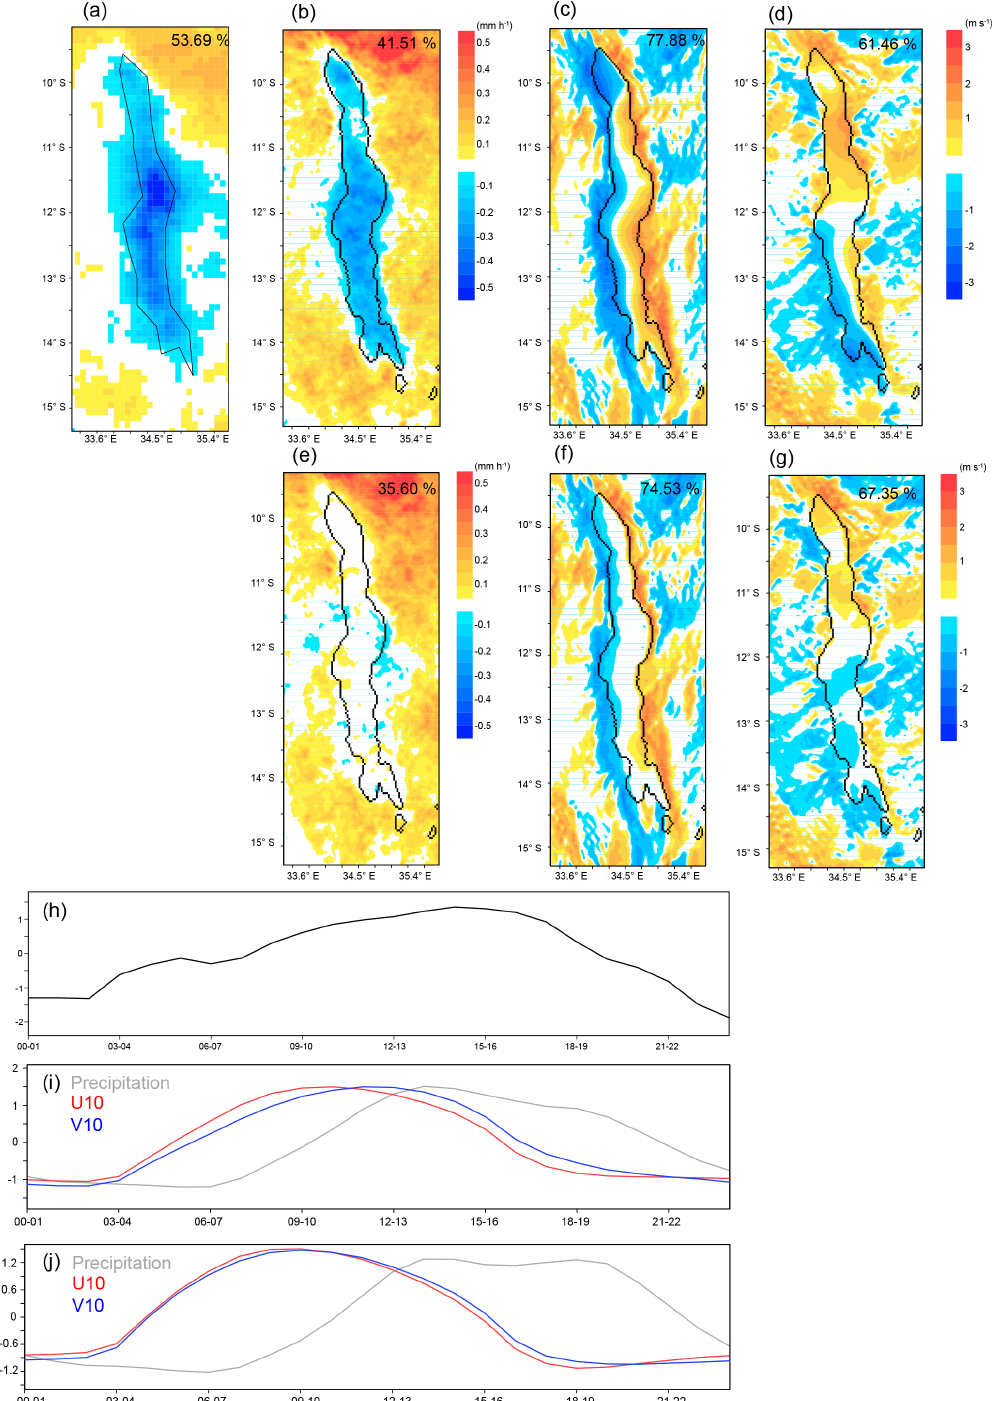
Figure 5. (a, b) The first modes of EOF analysis for precipitation of GPM and WRF-CTL for the NDJFM mean, respectively. (c, d) The first modes of EOF analysis for zonal and meridional surface winds of WRF-CTL for the NDJFM mean. (e–g) The first modes for WRFNOLM. (h) The time series of the PC1 score for (a) . (i, j) The time series of PC1 scores for WRF-CTL and WRF-NOLM. Each PC score is normalized by the standard deviation of each PC